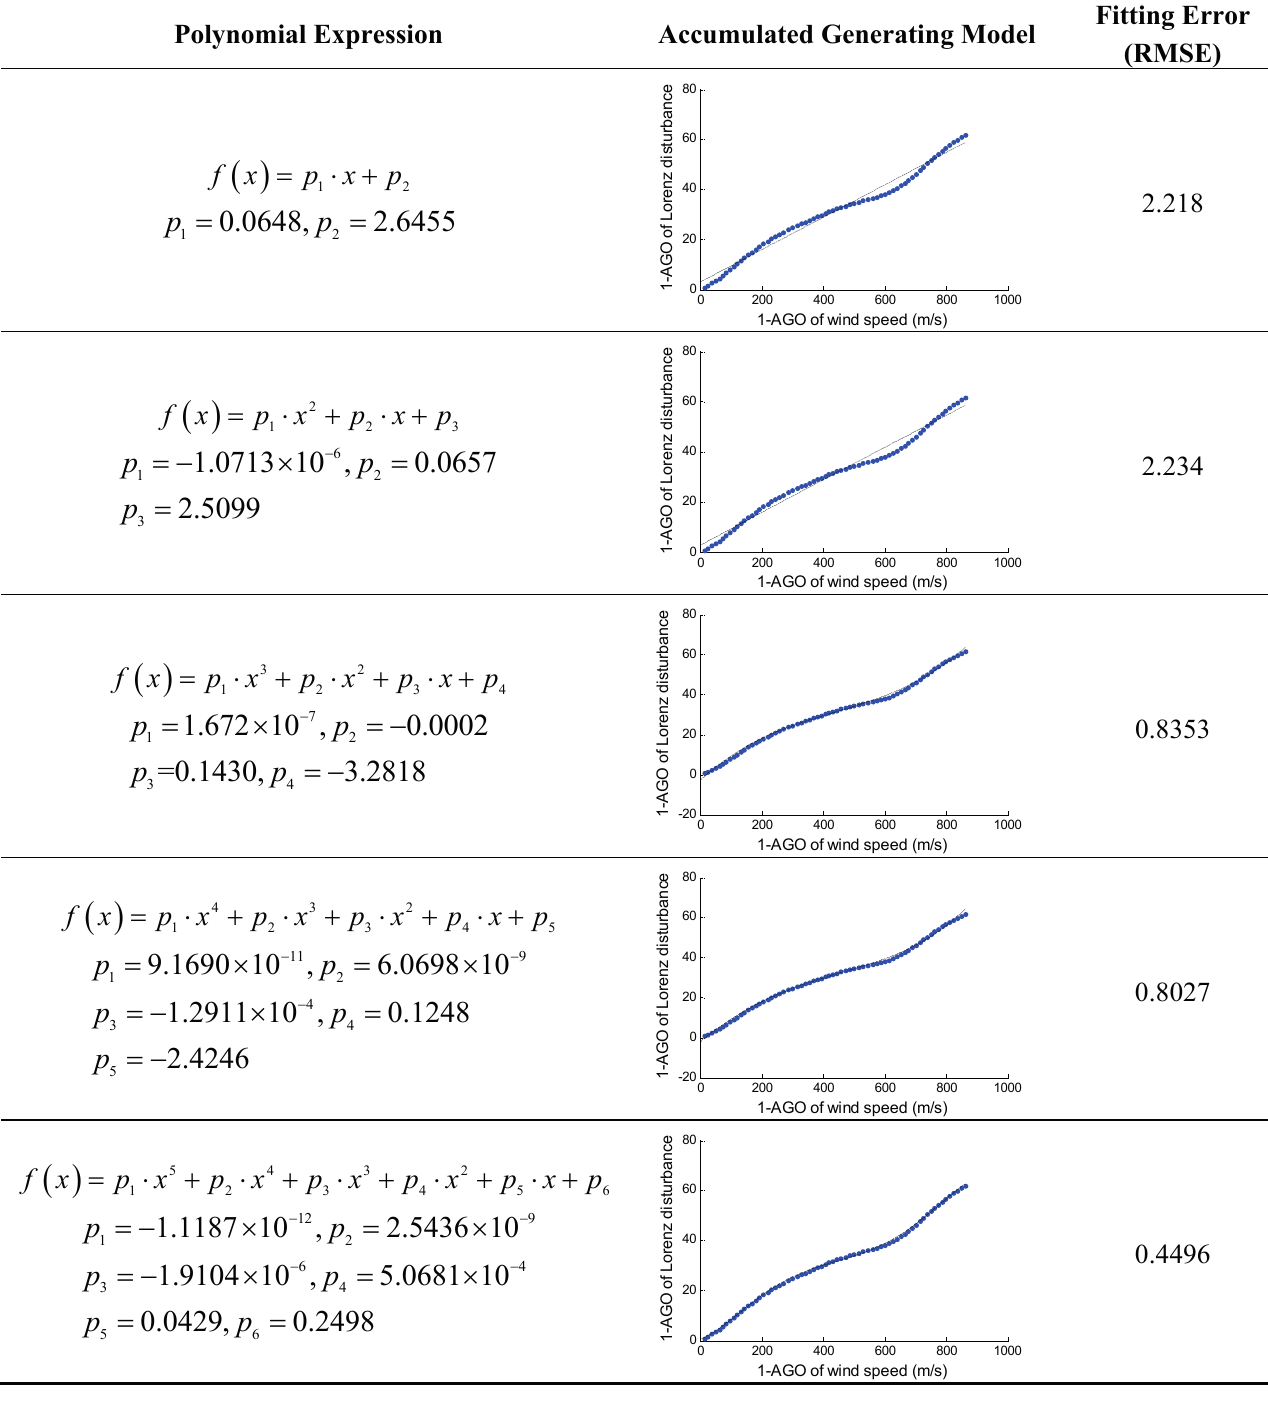
Table 2. Detailed statistics of grey generating models based on various polynomials. Polynomial Expression Accumulated Generating